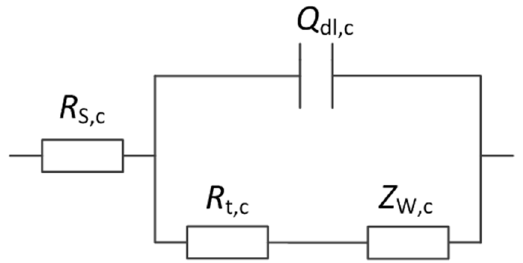
Figure 10. Equivalent circuit model for fitting the EIS measured at − 60 mV (vs. OCP) under different elastic and plastic tensile stress at 30 °C.